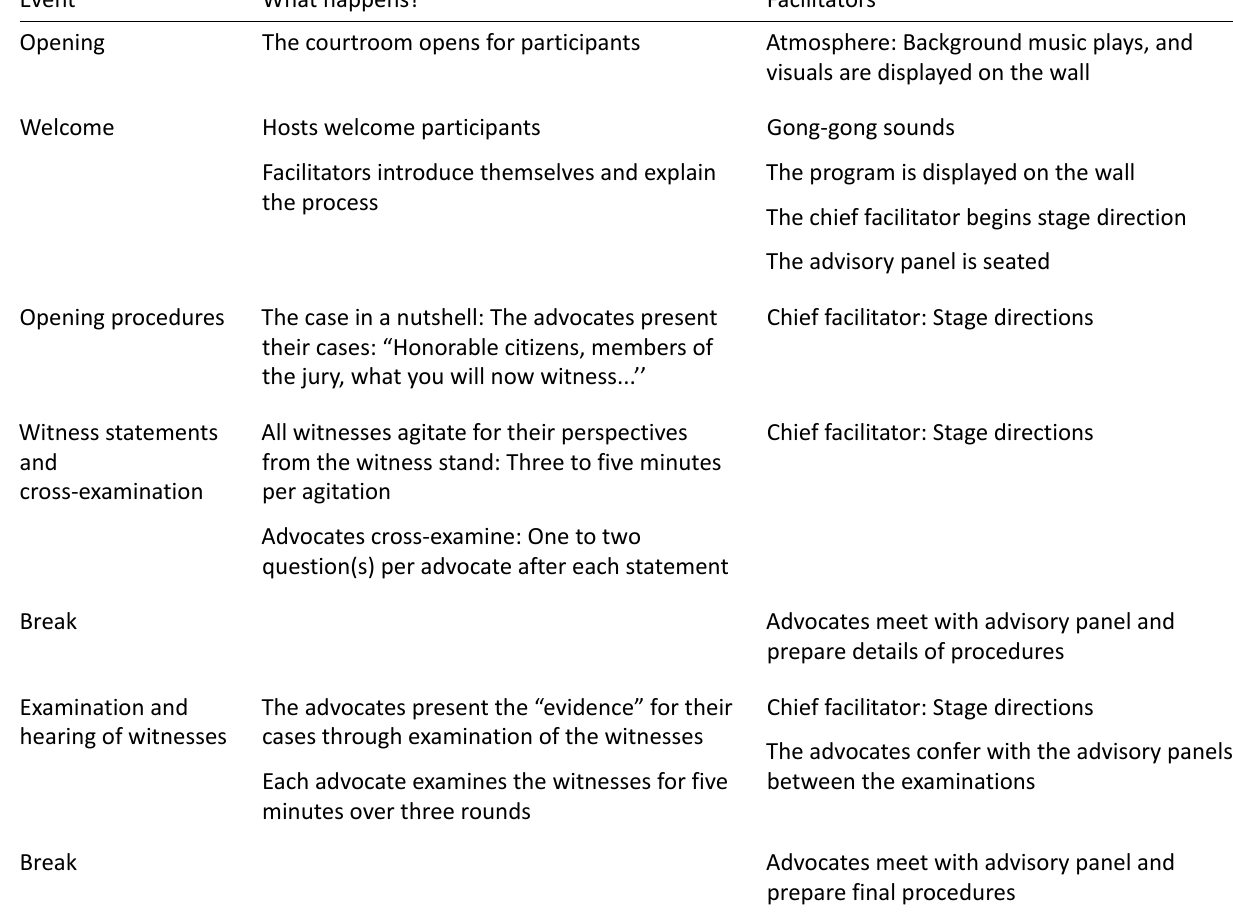
Table 1. Free Trial! dramaturgical script.